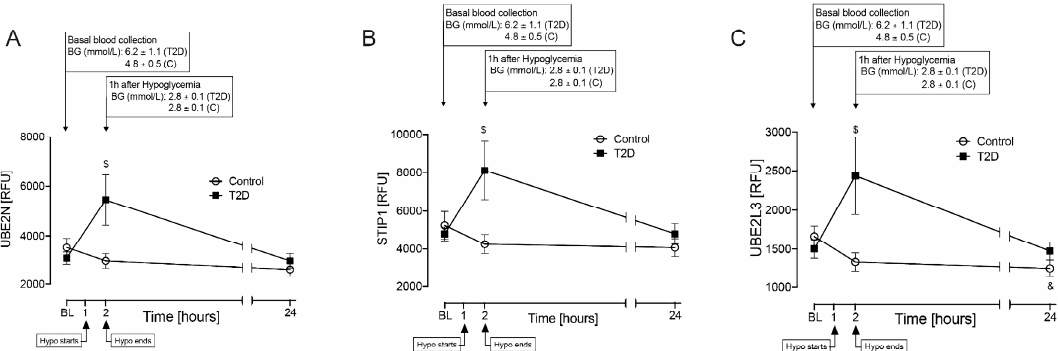
Figure 3. Comparison of plasma levels of the following heat shock proteins: ubiquitin-conjugating enzyme E2N (UBE2N), stress-induced phosphoprotein 1 (STIP1), and ubiquitin-conjugating enzyme E2L3 (UBE2L3) at baseline (BL), at hypo- glycemia, and 24 h post hypoglycemia in control and T2D cohorts. Controls (white circles), T2D (black squares). UBE2N ( A ), STIP1 ( B ), and UBE2L3 ( C ), proteins for which levels differed from baseline to hypoglycemia in T2D and control cohorts. Statistics: $ , p < 0.05, T2D BL vs. Hypo; & , p < 0.05, control BL vs. 24 h. RFU, relative fluorescent units; Hypo,